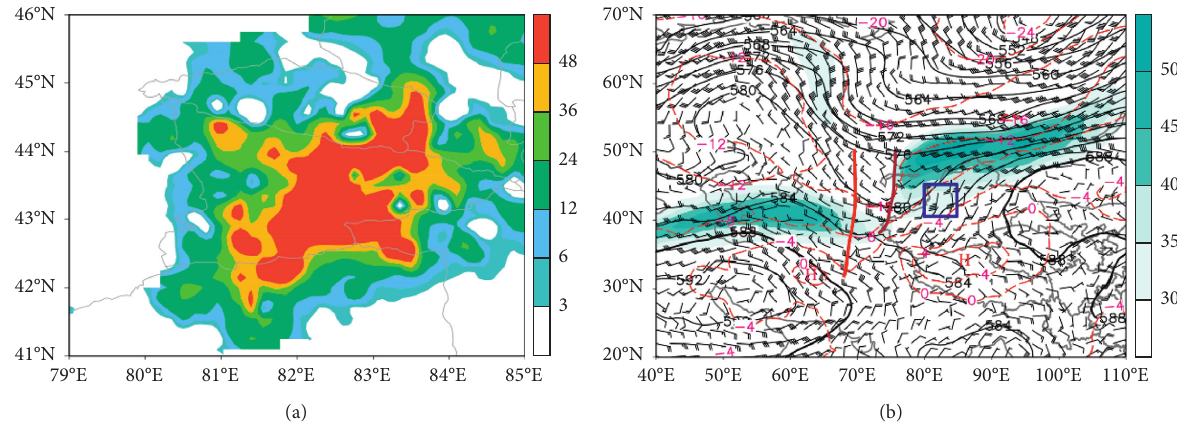
Figure 3: (a) The precipitation distribution in the Tianshan region from 12:00 on July 31 to 12:00 on August 1, 2016 (shadow, unit: mm). (b) The geopotential height of 500hPa (solid line; unit, dagpm), wind field (wind pole; unit, m · s − 1 ), and high-altitude jet stream at 200hPa at 12: 00 on July 31, 2016 (shadow; unit, m · s − 1 ) (the blue rectangle represents the location of the rainstorm area, the brown solid line represents the groove line, and the red solid line is the temperature groove line).